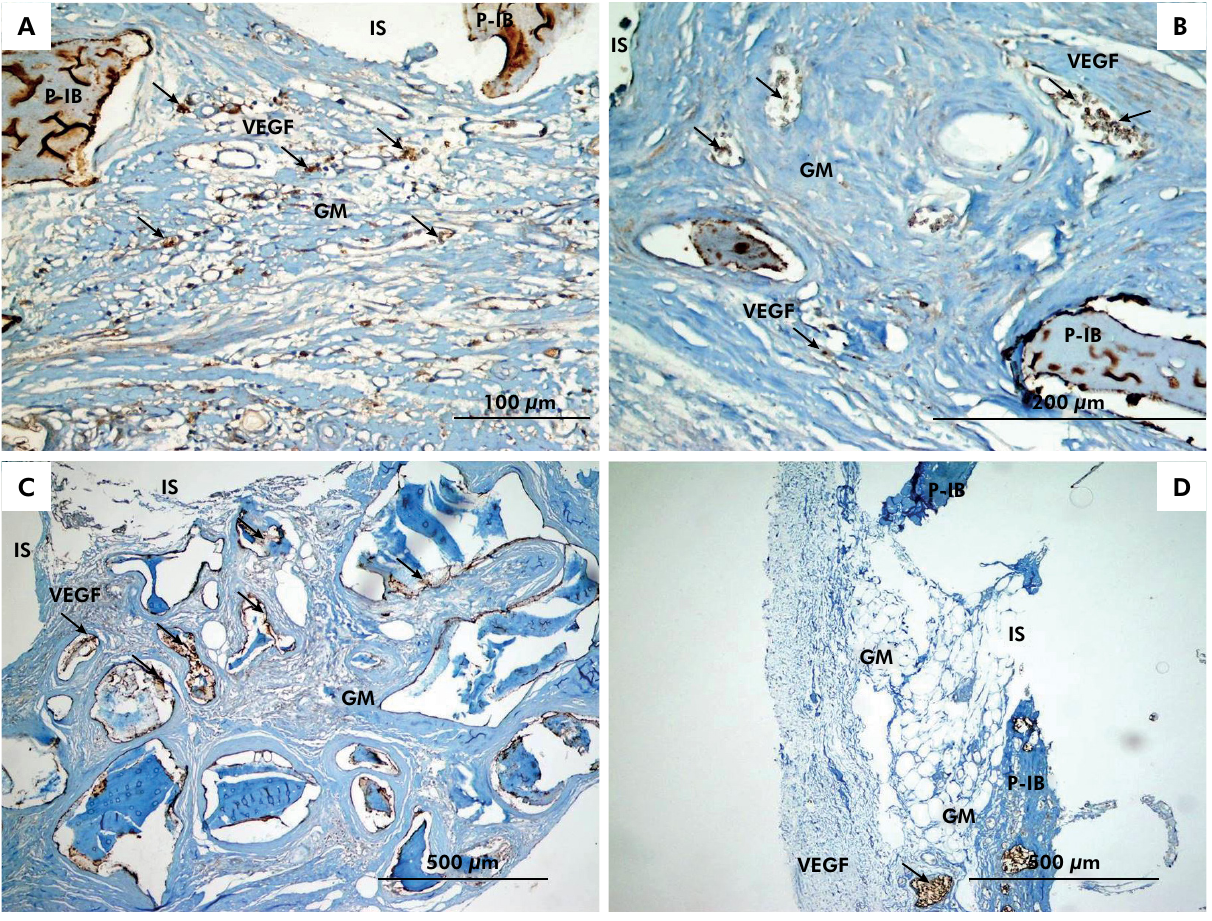
Figure 3. Immunohistochemical staining of VEGF in the a) calcium sulfate, b) deproteinized bovine, c) human-derived allogenic, and d) hydroxyapatite bone graft